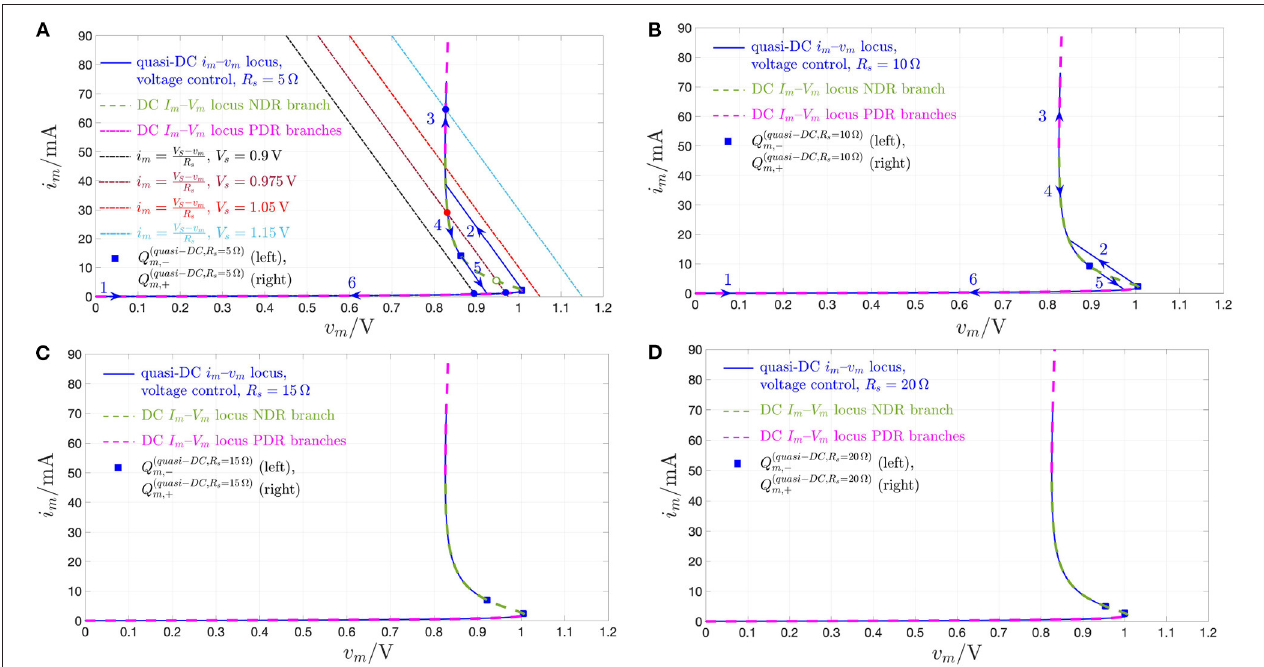
FIGURE 21 | Blue solid curves: Memristor quasi-static current-voltage loci over one cycle of a period- T triangular voltage signal applied across the series combination between the NaMLab micro-structure and a series resistor of variable resistance R s without any current limitation measure, as results from numerical simulations of the device polynomial model with initial condition x 0 253.15. The input period T was fixed to 10s, while, in order to achieve a similar range in quasi-DC memristor = v s of the voltage stimulus was appropriately increased as R s was assigned larger values. (A) R s currents, the amplitude ˆ v s v s (C) R s 15 (cid:127) , 1.925V. (D) R s 20 (cid:127) , 2.25V. The PDR branches (NDR branch) of the device DC current-voltage characteristic are (is) plotted in dashed ˆ ˆ = = = = line style and magenta (green) color. As studied in section 2(c), the larger is the value assigned to R